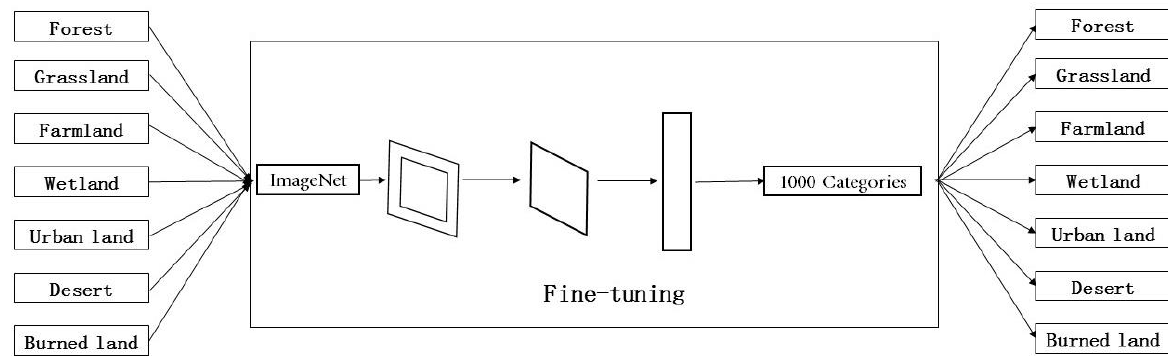
Figure 3. Fine-tuning strategy.